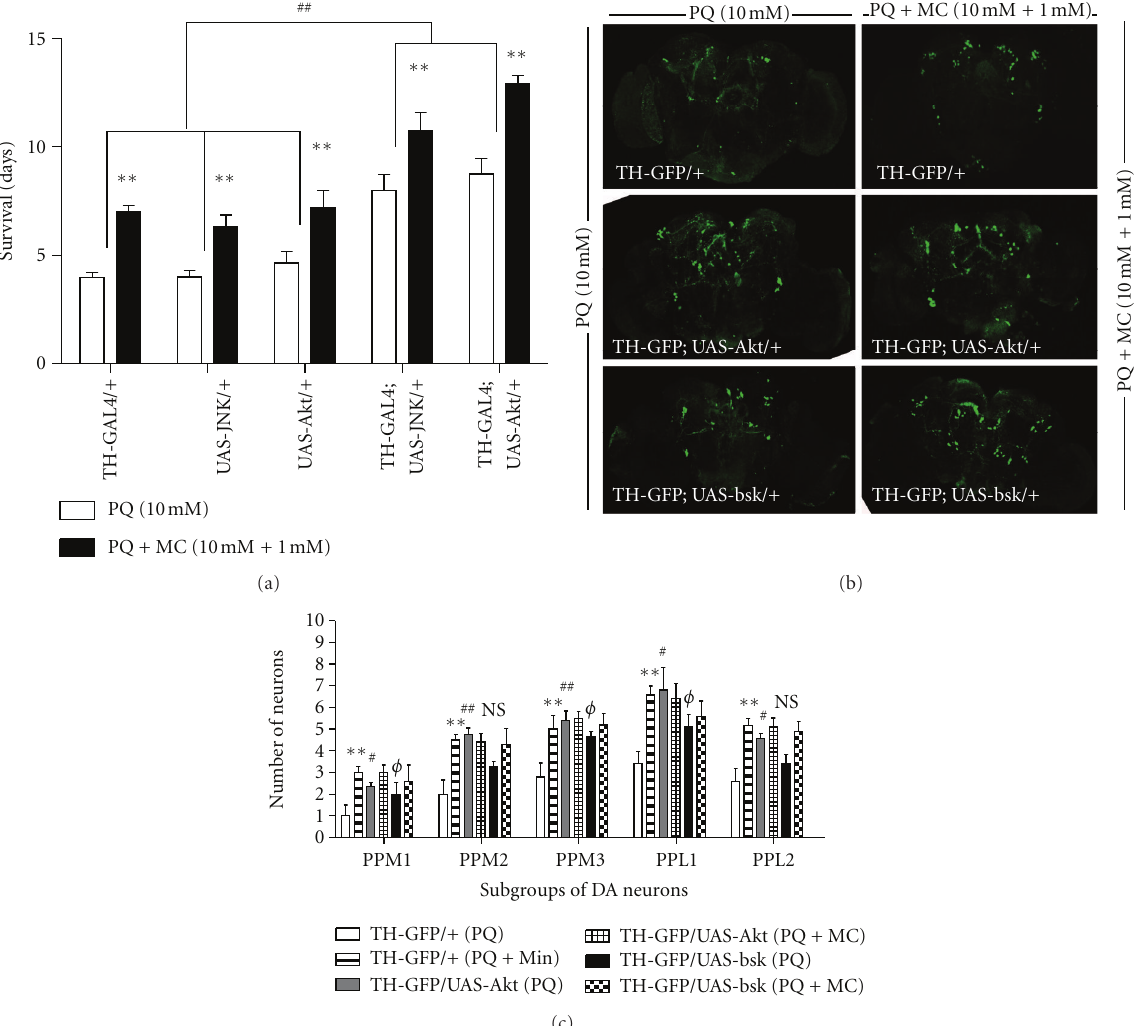
Figure 8: Overexpression of wild type BSK/JNK and Akt provides protection against PQ. (a) Adult males of genotypes TH - GAL4 /+, UAS - bsk 1 / +, UAS - Akt 1 / +, TH - GAL4 ; UAS - bsk 1 / +, and TH - GAL4 ; UAS - Akt 1 / + flies were fed, beginning at 48hr after eclosion, 10mM PQ or 10mM PQ and 1 mM MC. The average survival duration for each group was determined. ∗∗ = P < 0 . 005 and represents significant di ff erences between the PQ and PQ with MC groups. ## = P < 0 . 005, indicating a significant di ff erence between control and JNK or Akt expressing flies fed only PQ. Error bars represent standard error of the mean. Each data point represents at least three independent replications of 50–60 flies each. (b) The e ff ect of PQ (10mM) and PQ + MC (10 mM + 1mM) on brains of transgenic lines shown in the images. The overexpression of wild type Akt and Bsk/JNK in dopaminergic neurons provides protection to DA neurons against PQ, however; addition of MC in fails to provide additional protective to transgenic lines, TH-Gal4; UAS - eGFP/UAS - Akt WT and TH-GAL4; UAS - eGFP/UAS - bsk WT against PQ. (c) The average number of neurons per subset was determined 24 hr after the initiation of feeding in these transgenic lines. MC ingestion significantly improved the survival of DA neurons against PQ-induced loss of DA neurons in TH-Gal4; UAS-eGFP/+ brains.The overexpression of wild type Akt and JNK supports the survival of DA neurons against 10 mM PQ but addition of 1mM MC failed to provide additional protection against PQ mediated DA neuron loss in these transgenic lines. ∗∗ = P < 0 . 005 and represent significant di ff erences between PQ and PQ and MC-treated TH-Gal4; UAS-eGFP/+ brains. # represents significant di ff erences between PQ-treated TH-Gal4; UAS-eGFP/+ and PQ-treated TH-Gal4; UAS - eGFP/UAS - Akt WT and Φ represent significant di ff erences between PQ- treated TH-Gal4; UAS-eGFP/+ and PQ-treated TH-GAL4; UAS - eGFP/UAS - bsk WT brains, respectively. # / Φ = P < 0 . 05 while ## = P < 0 . 005. n = 8–12 brains for each transgenic lines. NS = not